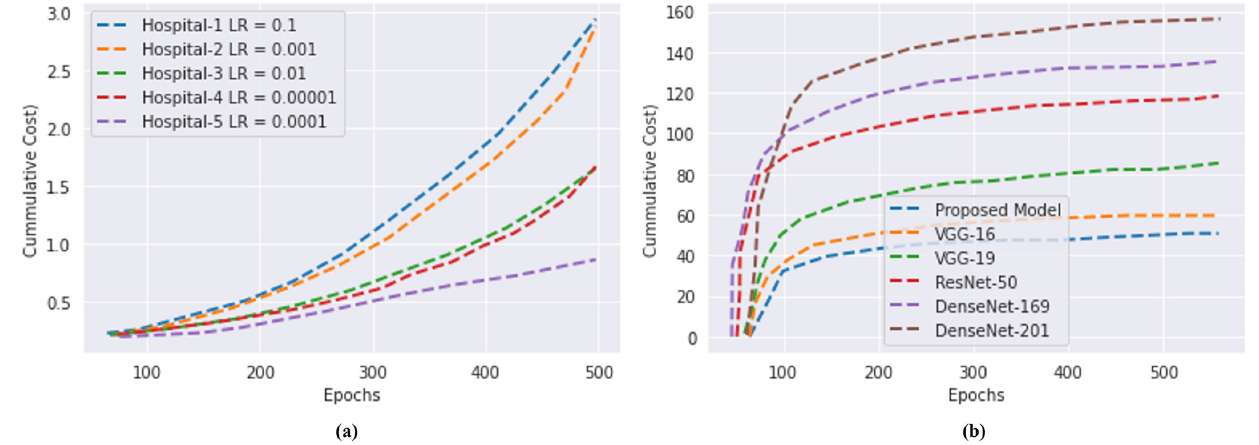
Figure 10 . Comparison of the computational cost of the models. ( a ) Proposed blockchain-based FL cost. ( b ) Computational cost comparison with five DL and FL.